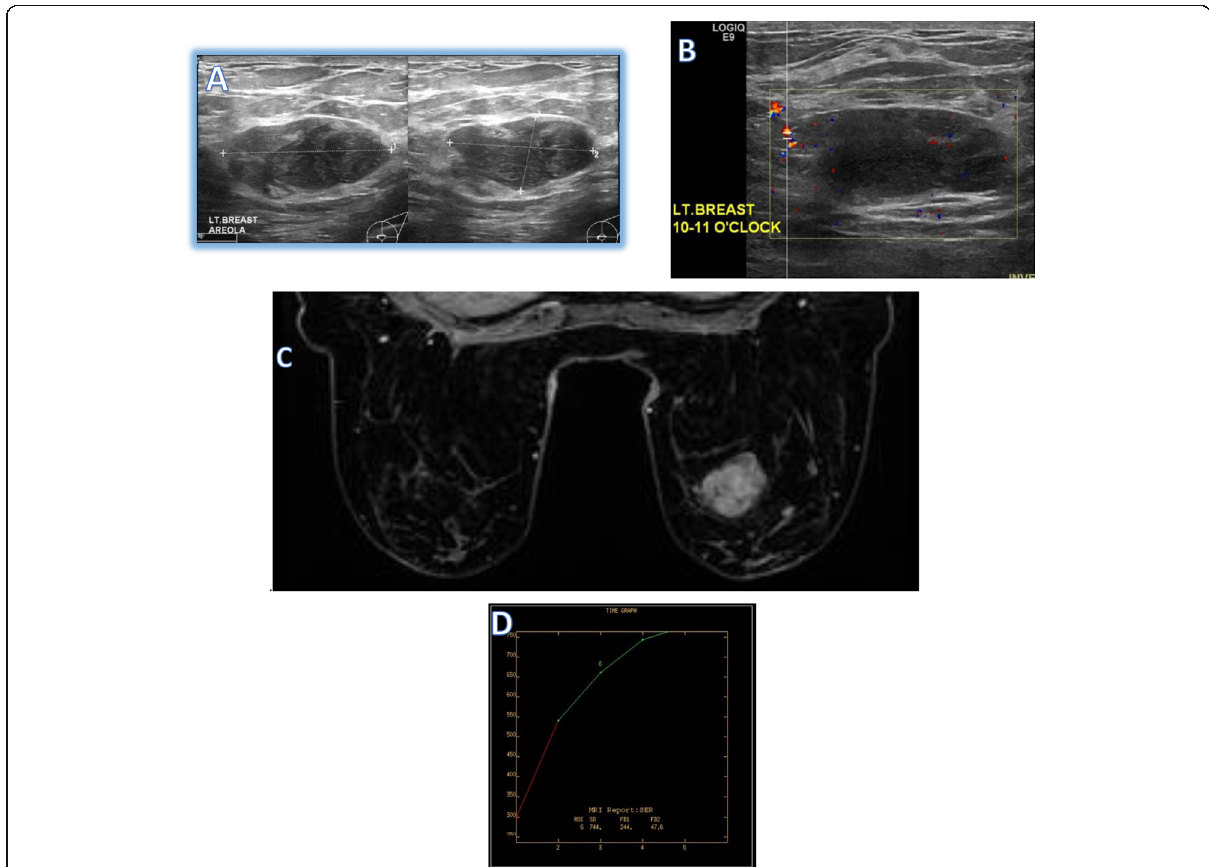
Fig. 7 A 22-year-old patient with history of left breast lump and strong family history of cancer breast. a and b US shows lobulated hypoechoic mass with vascularity inside (BIRADS III). c and d MRI revealed that mass appeared lobulated showed homogenous enhancement (type I kinetic time intensity curve) (category III MRI lexicon classifications) and biopsy confirmed fibro